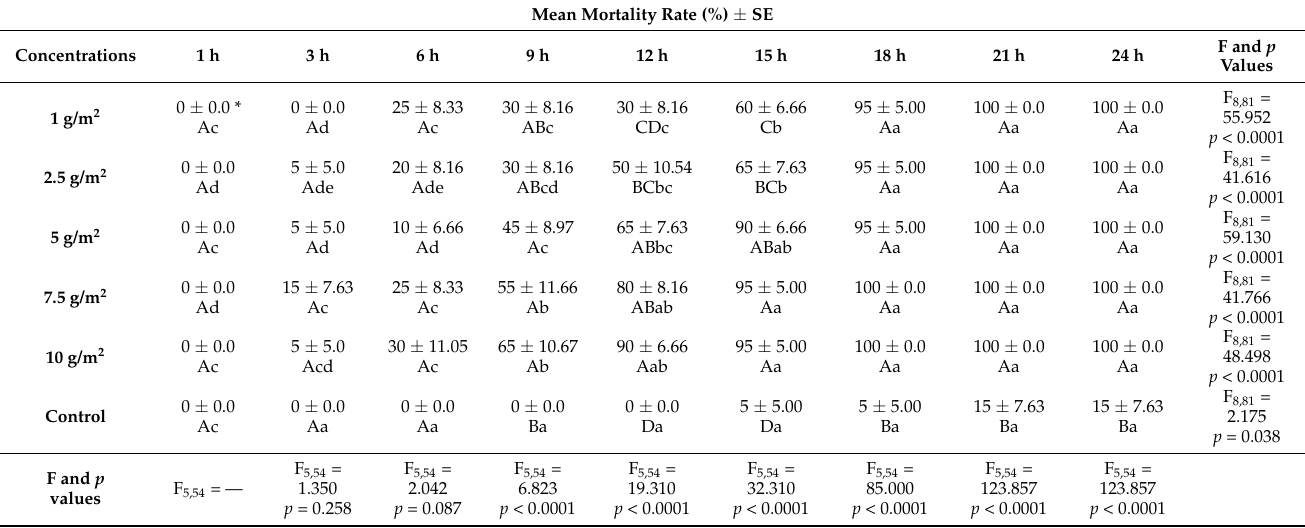
Table 3. Average mortality rate (mean + SE) of Tyrophagus putrescentiae exposed to five different concentrations of Detech ® Dust for certain time periods.